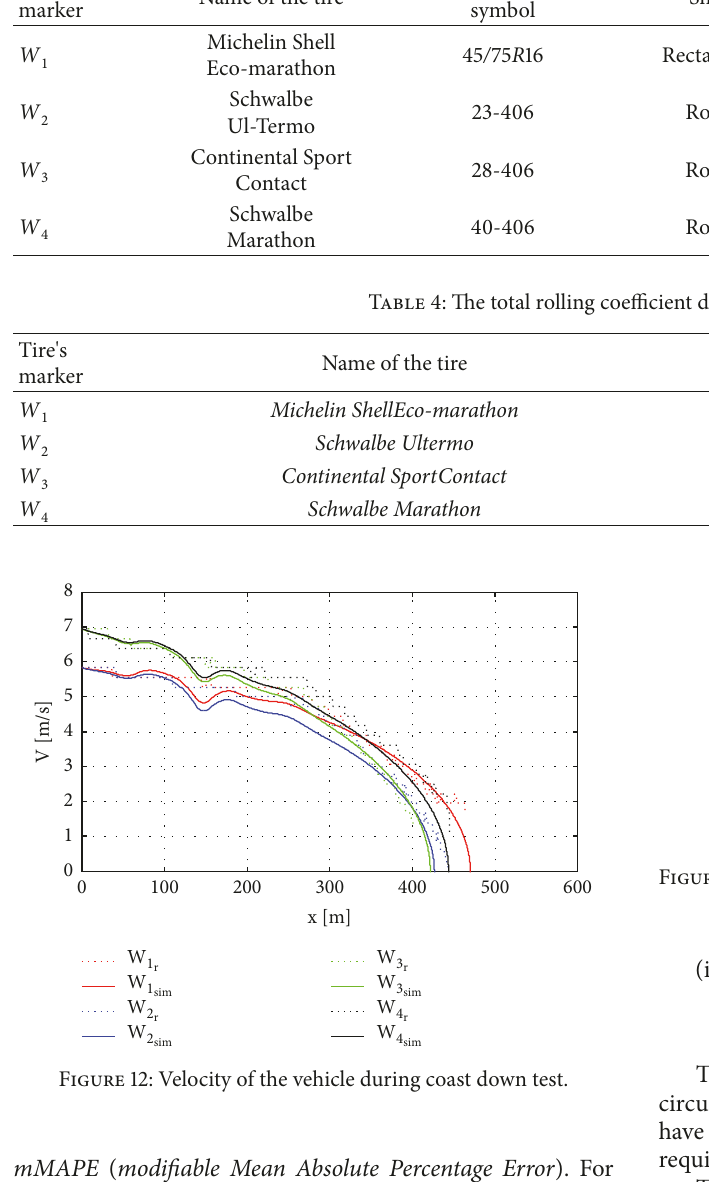
mMAPE ( modifiable Mean Absolute Percentage Error ). For